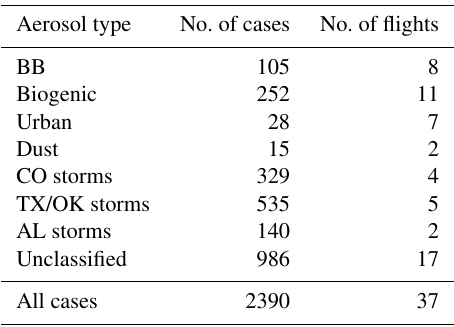
sified”. A decision tree specifying the requirements for each SEAC 4 RS category is shown in Fig. 1.